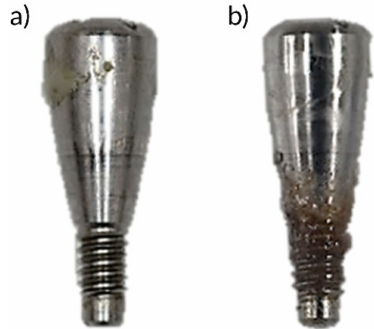
Figure 3. Macroscopic evaluation of carrier sustainability. ( a ) No residue and ( b ) residual agent visible at the subgingival part of healing